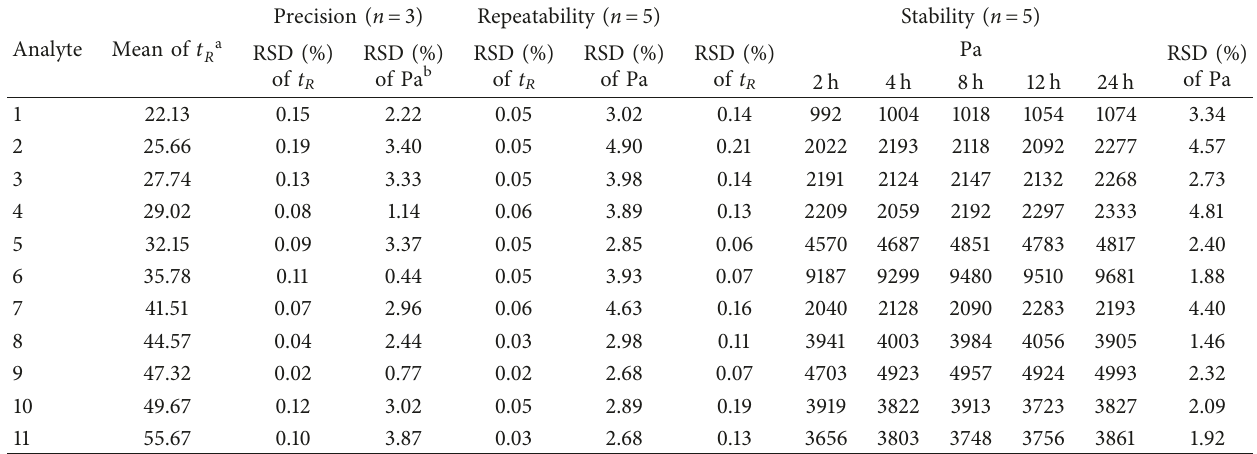
Table 2: Precision, repeatability, and stability of eleven analytes in HPLC.